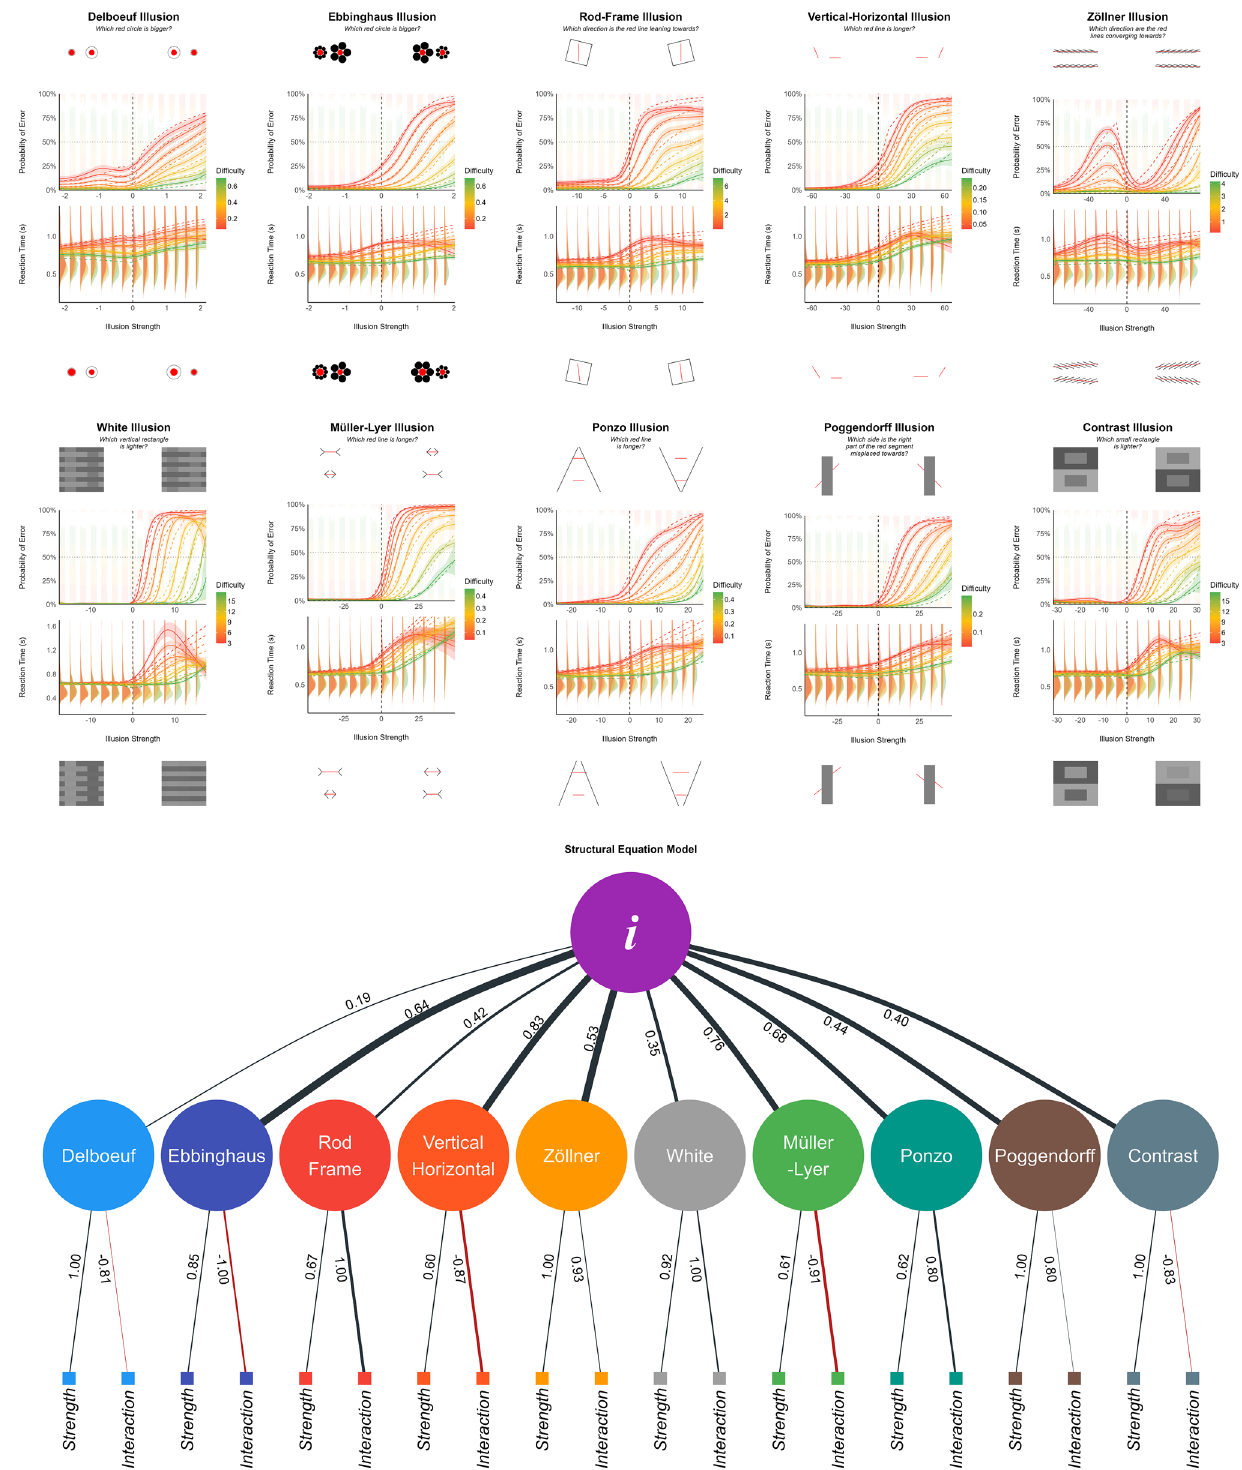
Figure 3. Top: the effect of illusion strength and task difficulty on the error rate and reaction time (RT) for each individual illusion. The solid line represents the General Additive Model (GAM), and the dashed line corresponds to its approximation via linear models. Descriptive data is shown with stacked dots (for which errors start from the top) and distributions for RTs. Negative values for illusion strength correspond to congruent (i.e., facilitating) illusion effects. Task difficulty (the objective difference between the targets of perceptual decision) levels are shown as colors, with lower values corresponding to harder trials. The results for each illusion are surrounded by 4 extreme examples of stimuli, corresponding to the hardest difficulty (on top) and the strongest illusion (on the right for incongruent illusions). Bottom: We extracted the effect slope of the illusion strength and its interaction with task difficulty for each participant. We fitted a Structural Equation Model (SEM) suggesting that these manifest variables group to first-level illusion-specific latent factors, which then load on a general factor of illusion sensitivity (Factor i